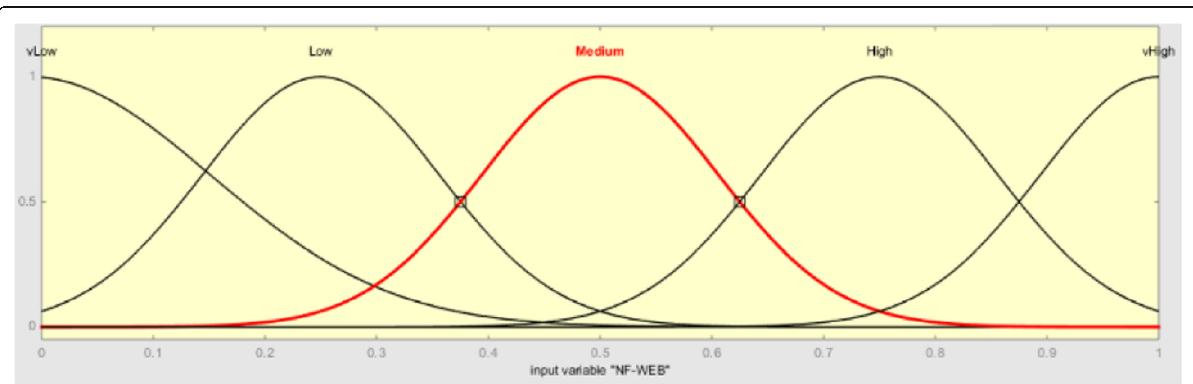
Fig. 2 First input variable “ Normalized Web Frequency ”